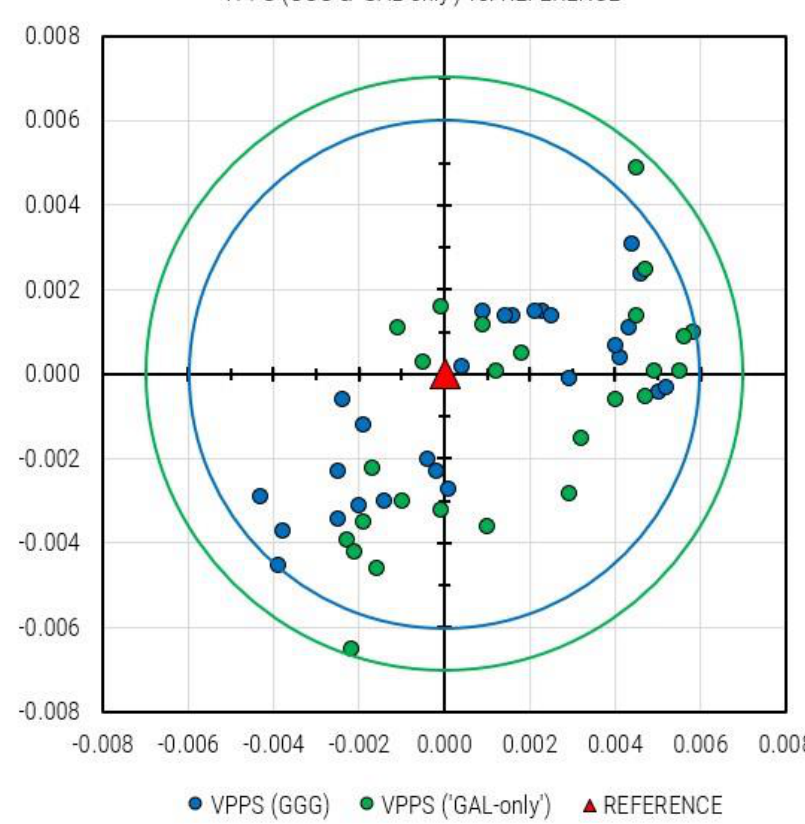
Figure 12. All VPPS solutions obtained: GGG (27 solutions; cyan dots) and GAL-only (26 solutions; green dots); the REFERENCE solution is marked with a red triangle.